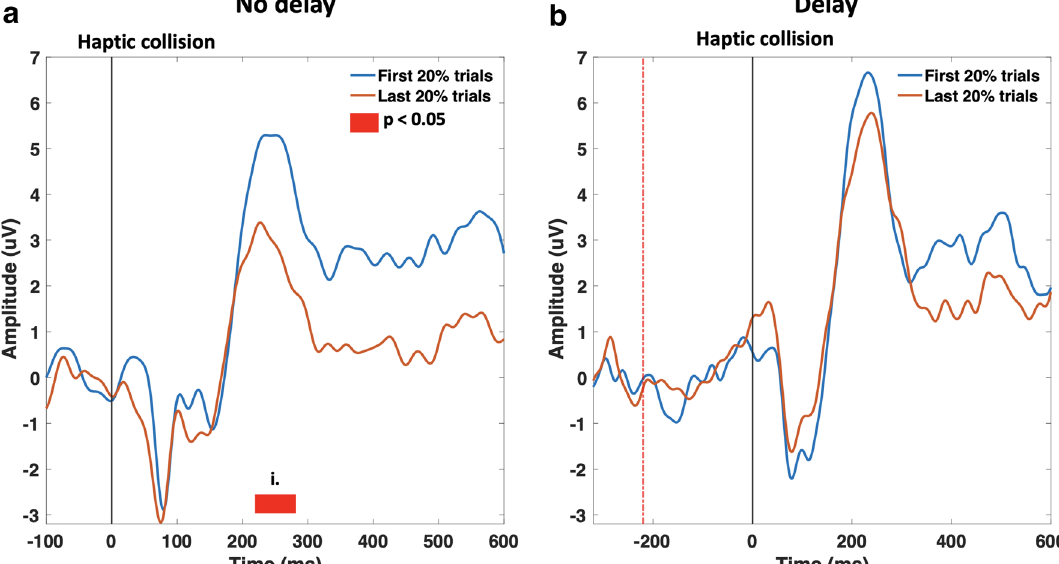
Figure 8. Learning effect due to repetitive exposure to the haptic collision across trials during the passive task. ( a ) P200 peak amplitude significantly ( p < 0.05 , randomization test, FDR corrected; t range = [220–280 ms]) reduces in the last ten trials in the absence of haptic delay compared to the first ten trials. ( b ) In the presence of haptic delay, however, there is no statistical significant difference between the first 10 and last 10 trials’ peak amplitude ( p > 0.05 , randomization test, FDR corrected; t range = [220–280